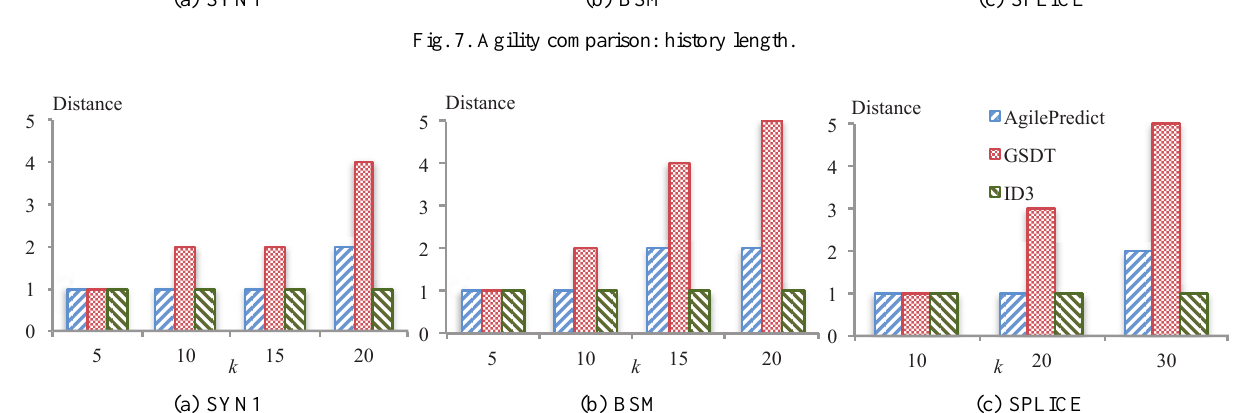
Fig. 7. Agility comparison: history length.